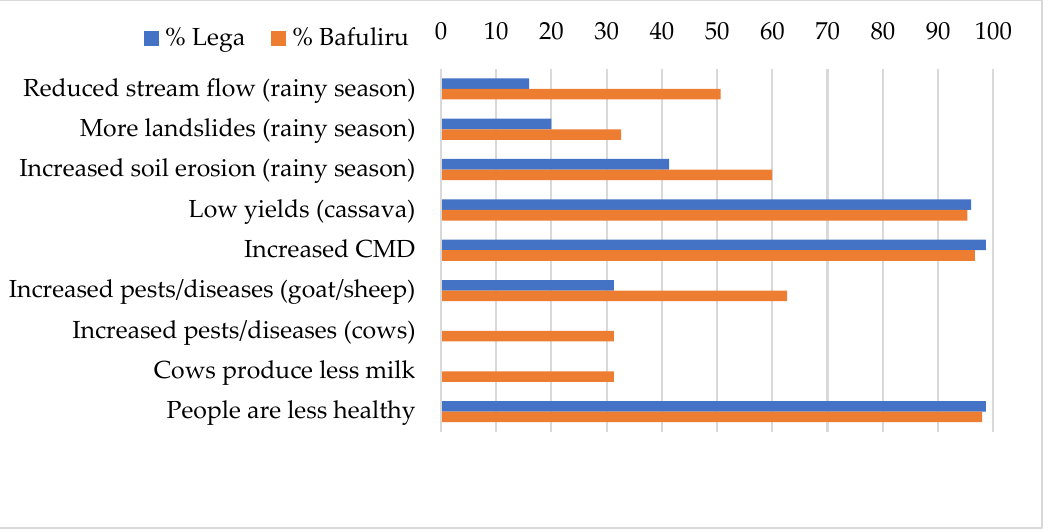
Figure 3. Perceived impacts per ethnic group ( n = 150 Bafuliru, n = 150 Lega). CMD: cassava mosaic disease.